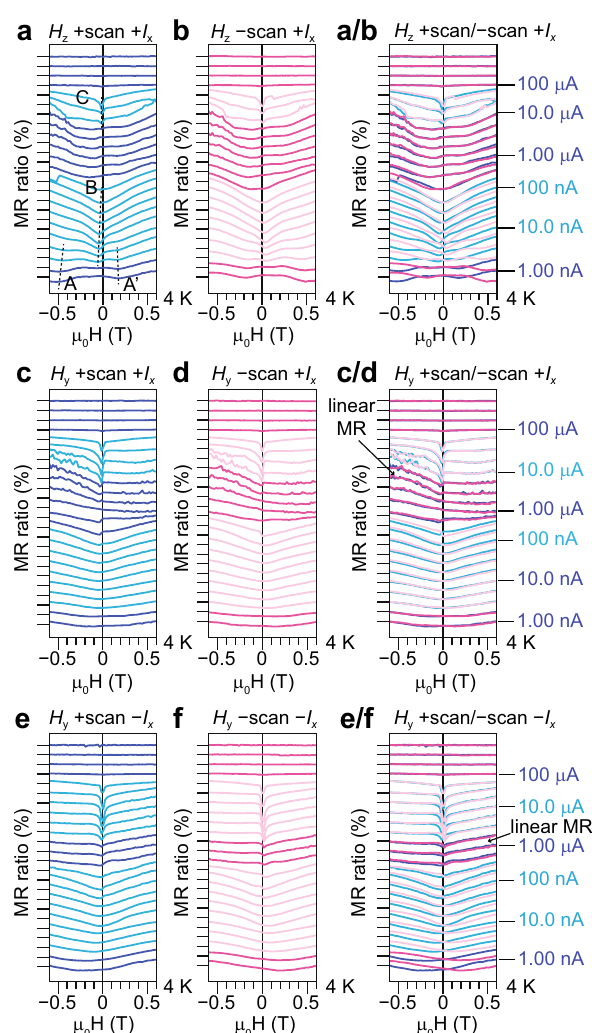
Figure 3. Magnetoresistance measured with various current intensities at 4 K. The current increases in steps of 1.78 times. ( a , b ) Magnetic field is applied along the out-of-plane direction ( H z ). ( c – f ) Magnetic field is applied along the in-plane direction crossing the current ( H y ). The current directions are + I x ( a – d ) and − I x ( e , f ). The magnetic field is swept from positive to negative (+ scan) in ( a , c , e ) and from negative to positive (− scan) in ( b , d , f ). ( a / b , c / d , e / f ) are superimposed together with + scan and − scan curves. The tick on the left axis indicates 0 in each curve. The tick space indicates